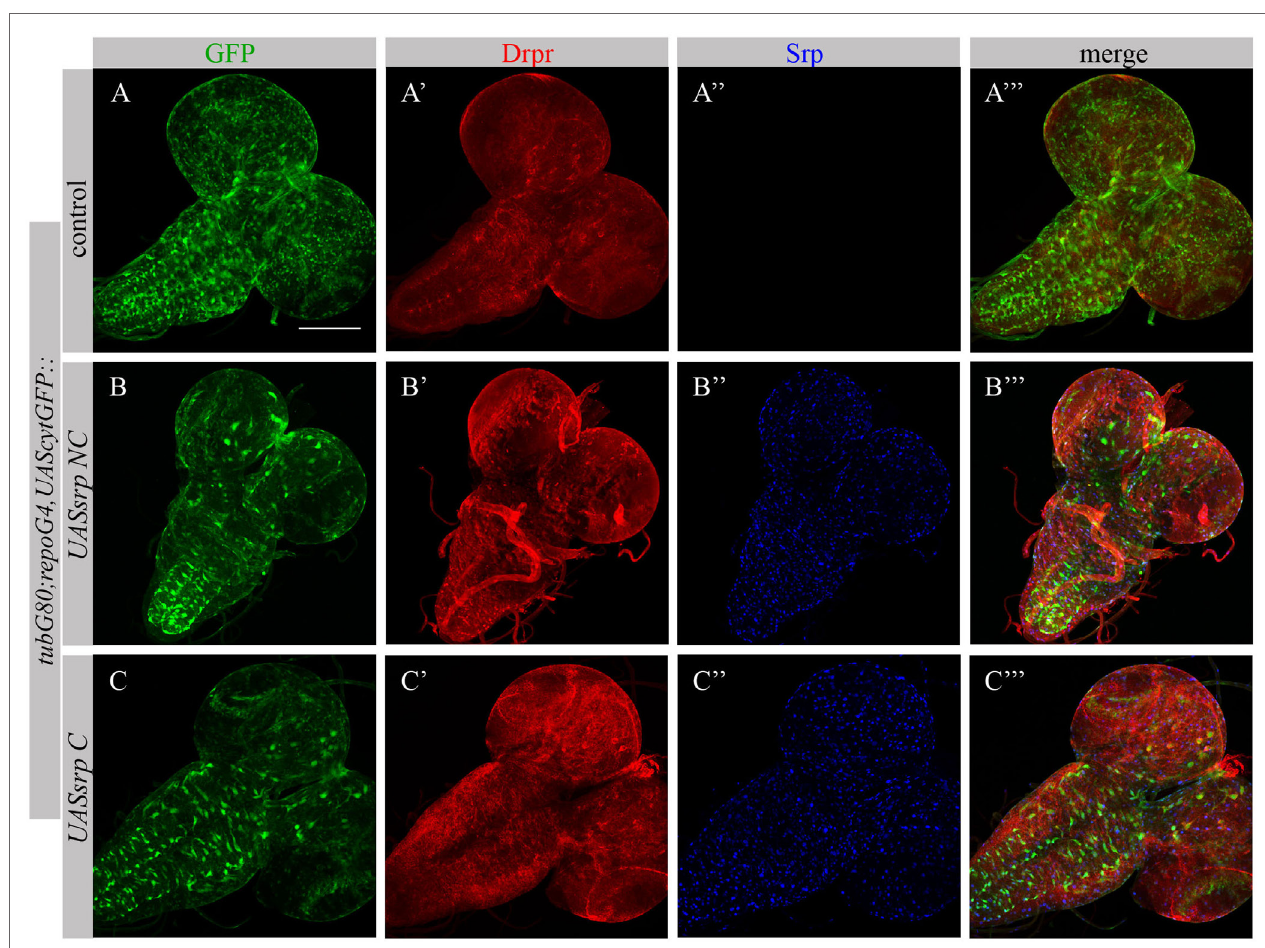
FigUre 7 | Each Srp isoform (SrpC and SrpNC) is sufficient to drive Drpr expression. (a–c’’’) Projections from confocal stacks of the 3 rd instar larval brains stained with anti-Drpr [red, (a’,a’’’,B’,B’’’,c’,c’’’) ], glia are labeled with repoGal4,UAScytGFP [green, (a,a’’’,B,B’’’,c,c’’’) ], anti-Srp [blue, (a’’,a’’’,B’’,B’’’,c’’,c’’’) ]. Bar, 100